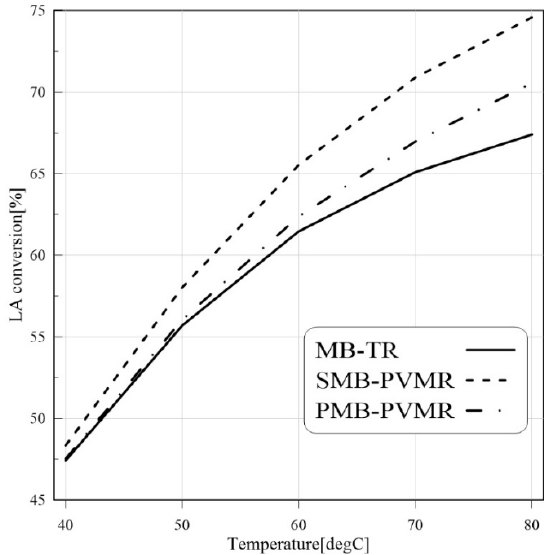
Figure 7. Comparison of LA conversion in MB-TR, PMB-PVMR, and SMB-PVMR based on variations in temperature. Et/LA:1 and feed flow rate: 10 mm 3 /s and W:8.6 g.